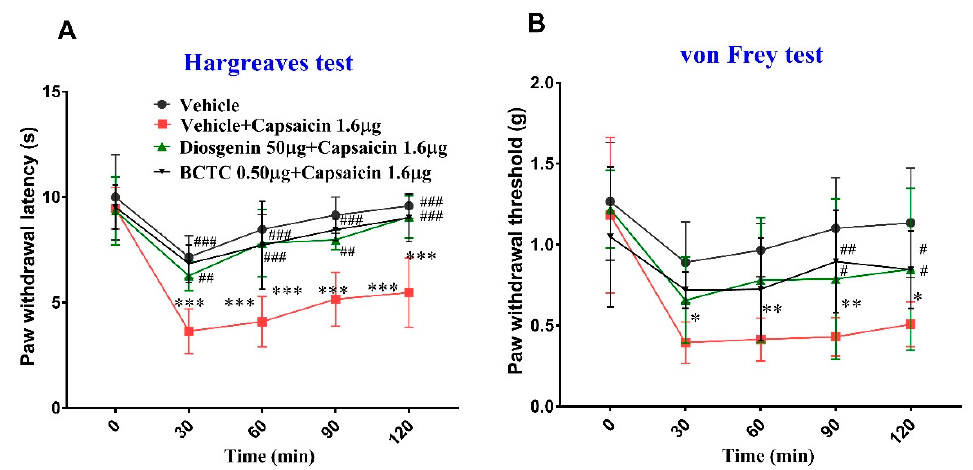
Figure 2. Intraplantar diosgenin treatment reduces capsaicin-induced acute thermal hyperalgesia ( A ) and mechanical allodynia ( B ) in mice; BCTC: N -(4-tertiarybutylphenyl)-4-(3-cholorphyridin-2-yl) tetrahydropyrazine-1(2H)-carbox-amide. Data are presented as mean ± standard error of mean (n = 6), * p < 0.05, ** p < 0.01 and *** p < 0.001, Bonferroni post hoc test following two-way RM ANOVA versus the vehicle group; # p < 0.05; ## p < 0.01; and ### p < 0.001, Bonferroni post hoc test following two-way RM ANOVA versus the vehicle + capsaicin 1.6 µ g